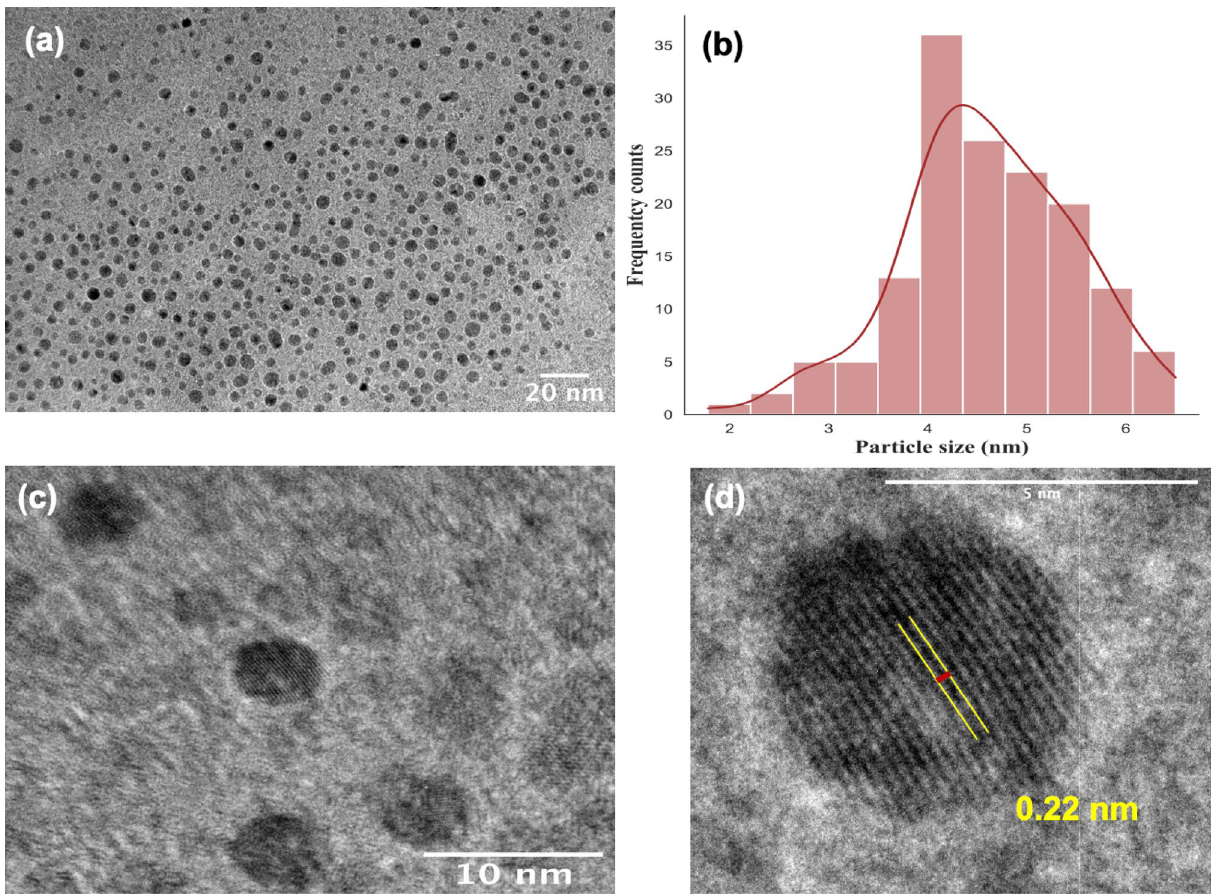
Figure 1. HRTEM images of N-CQDs at different magnification and scale: ( a ) 20 nm, ( c ) 10 nm, ( b ) particle size Gaussian distribution histogram, ( d ) graphitic core lattice. The N-CQDs have commonly a particle size of 4.60 ± 0.87